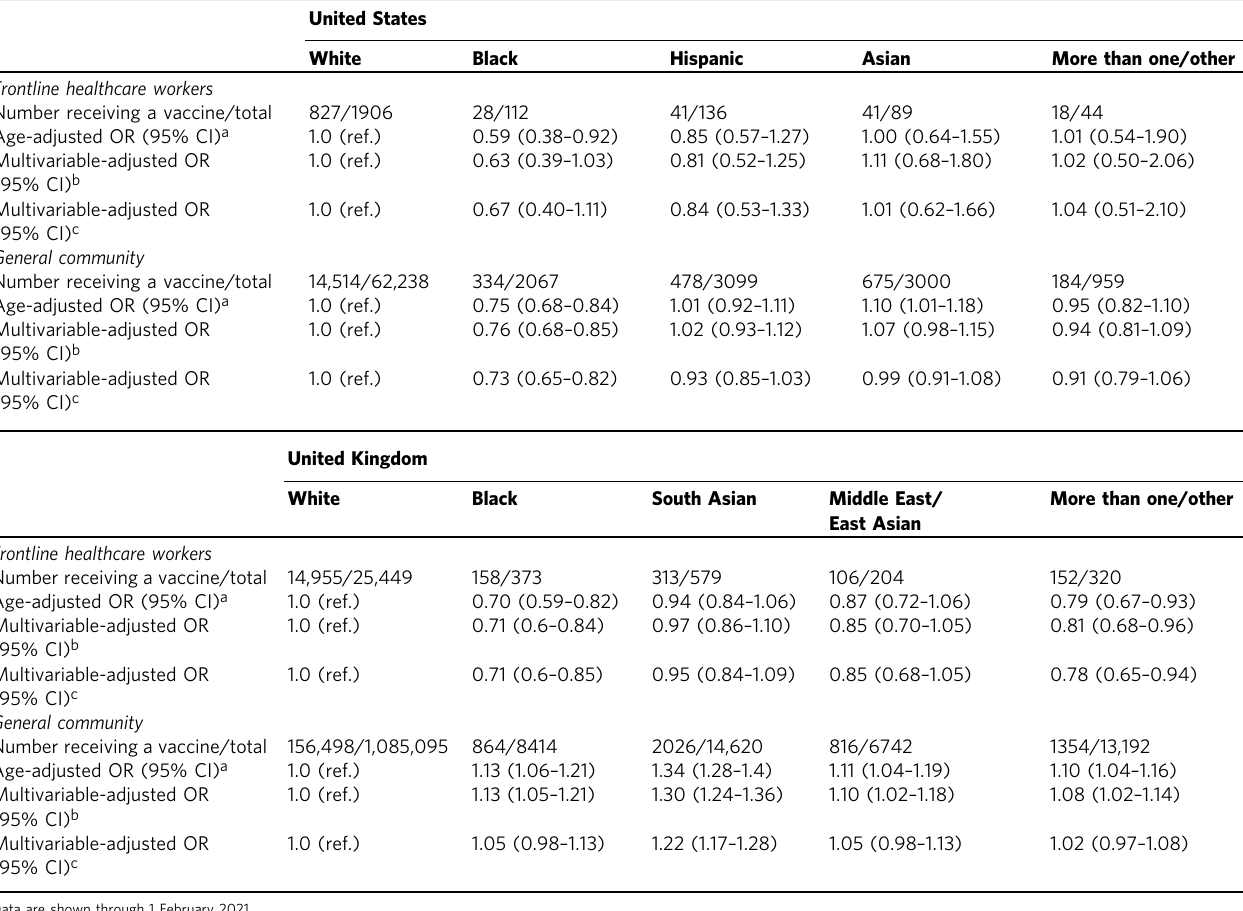
Table 4 Vaccine uptake by race and ethnicity according to country of enrollment among frontline healthcare workers and the general